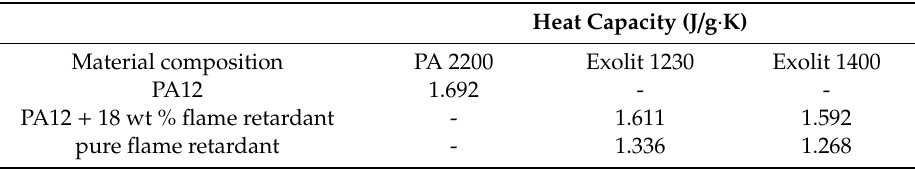
Table 4. Heat capacity of the polymer and composite powders at 23 °C.